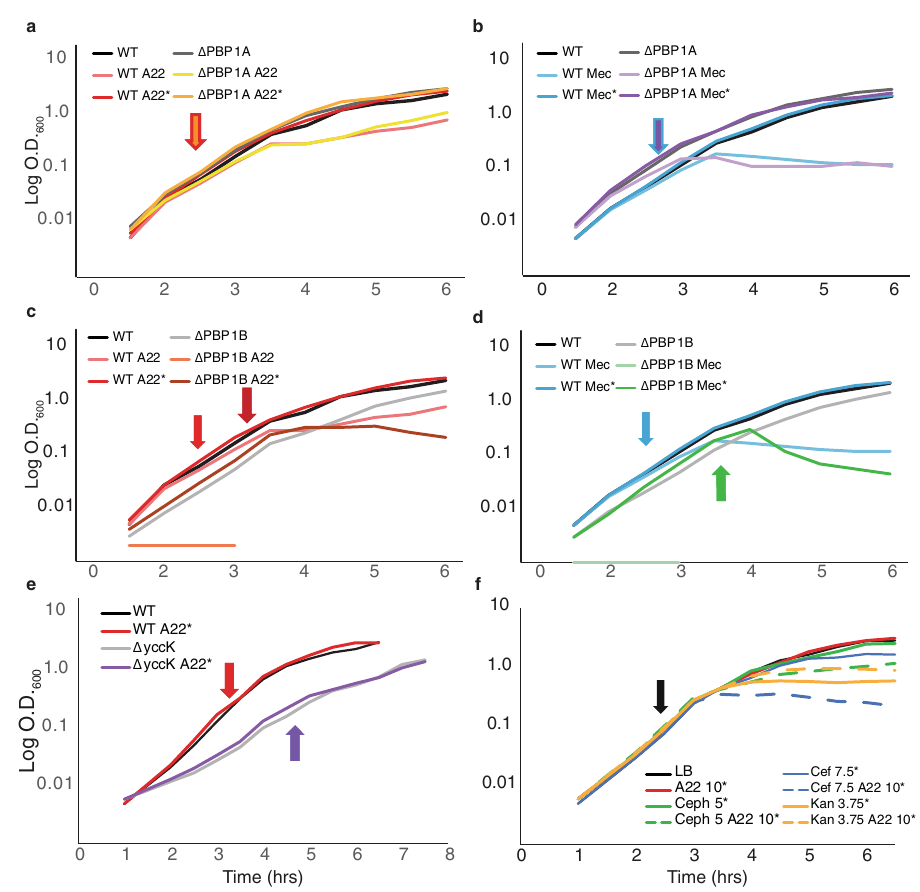
Fig. 5 PBP1B is responsible for density-dependent growth resistance. Representative growth curves cells grown at 37 °C in LB. a WT and Δ PBP1A cells were grown in A22, A22 (10 μ g/ml), and A22 added at the indicated times where OD 600 ~0.1 (*). Arrow coloration corresponds to which strains were spiked at that time. b WT, Δ PBP1A cells were grown in mecillinam, mecillinam (3 μ g/ml), and mecillinam added at the indicated time per strain where OD 600 ~0.1 (*). c WT and Δ PBP1B cells were grown in A22, A22 (10 μ g/ml), and A22 added at the indicated times where OD 600 ~0.1 (*). Arrow coloration corresponds to which strains were spiked at that time. d WT and Δ PBP1B cells were grown in mecillinam, mecillinam (3 μ g/ml), and mecillinam added at the indicated time per strain where OD 600 ~0.1 (*). e WT and Δ tusE cells in LB and A22 (10 μ g/ml) were added at the indicated time per strain where OD 600 ~0.1 (*). f Representative growth curve of WT cells grown at 37 °C in LB without antibiotics and the indicated antibiotics at the concentrations ( μ g/ ml) added at the indicated time where OD 600 ~0.1 (arrow and